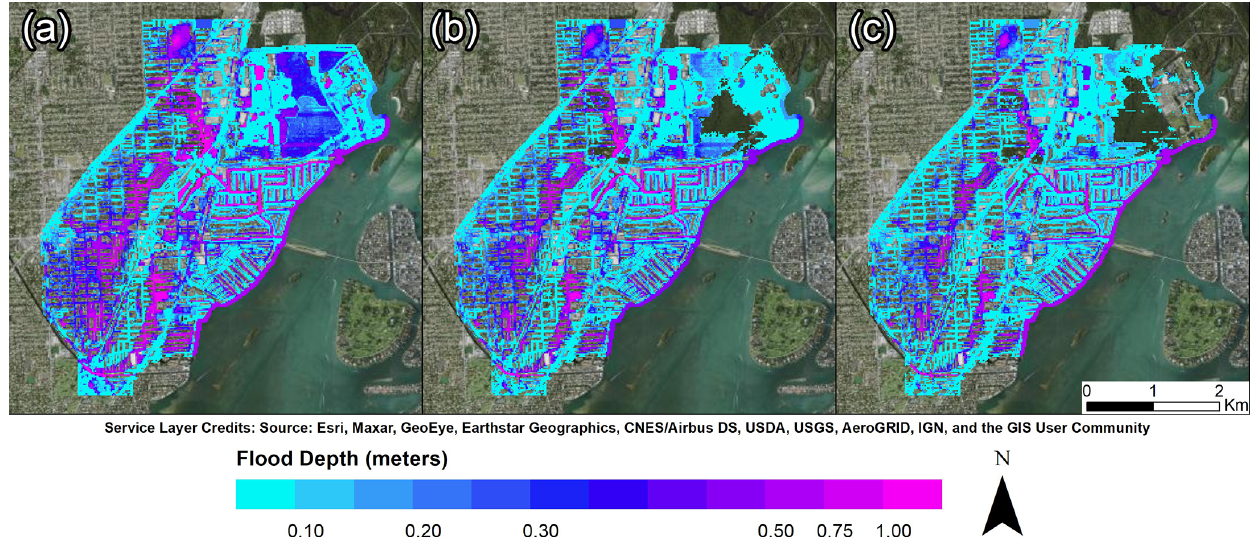
Figure 9. Spatial distribution of maximum inundation depths for Tropical Storm Leslie (a) , Tropical Storm Andrea (b) and the 25 May 2020 event (c) .